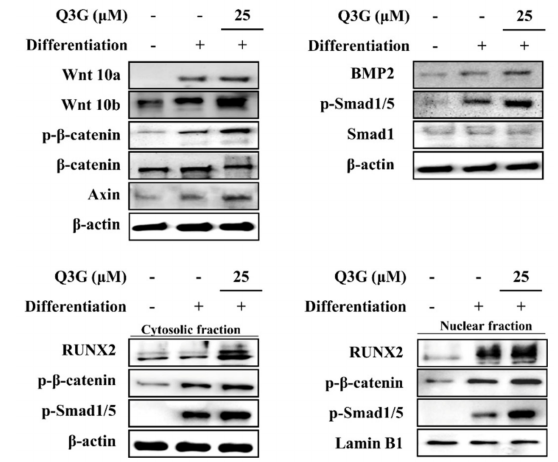
Figure 5. E ff ect of Q3G on Wnt / β -catenin and BMP signaling pathways. Analysis of protein expression was carried out by Western blotting of osteo-induced hBM-MSCs at day 10 di ff erentiation. Q3G was treated with initial di ff erentiation induction (3 days) and it was not present in subsequent media changes. β -actin (for whole cell and cytosolic fraction) and lamin B1 (for nuclear fraction) were used as internal loading